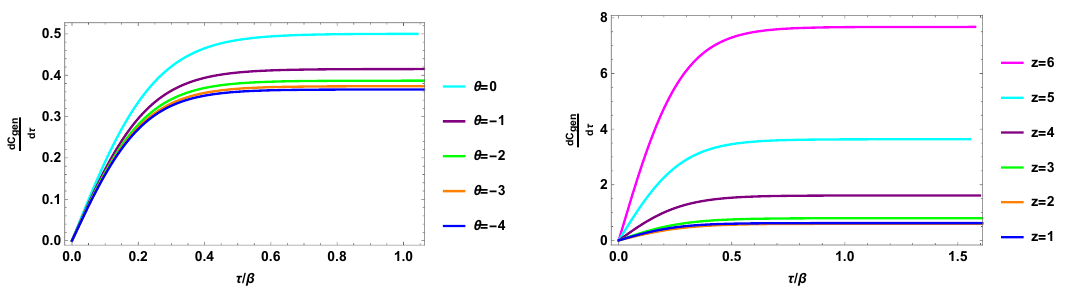
+ λ µν + 1 R 2 R µν R